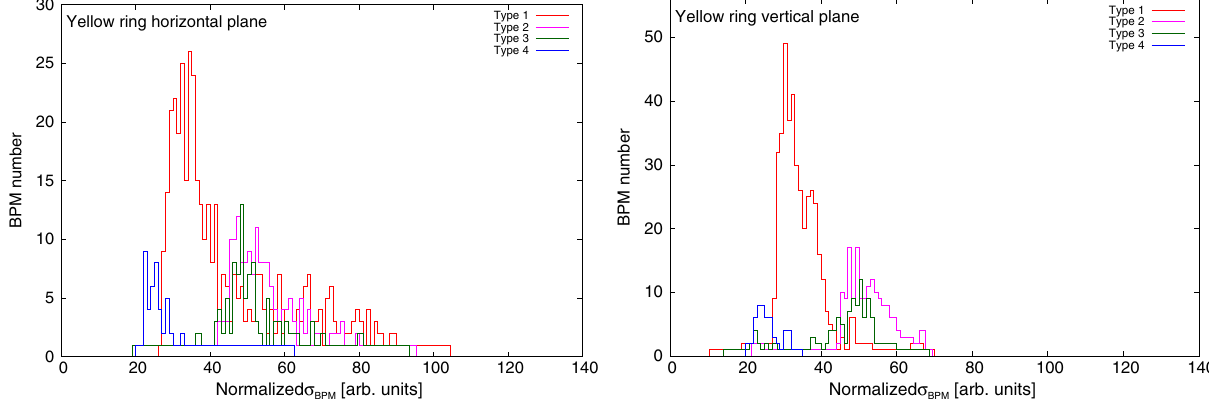
Yellow ring horizontal plane